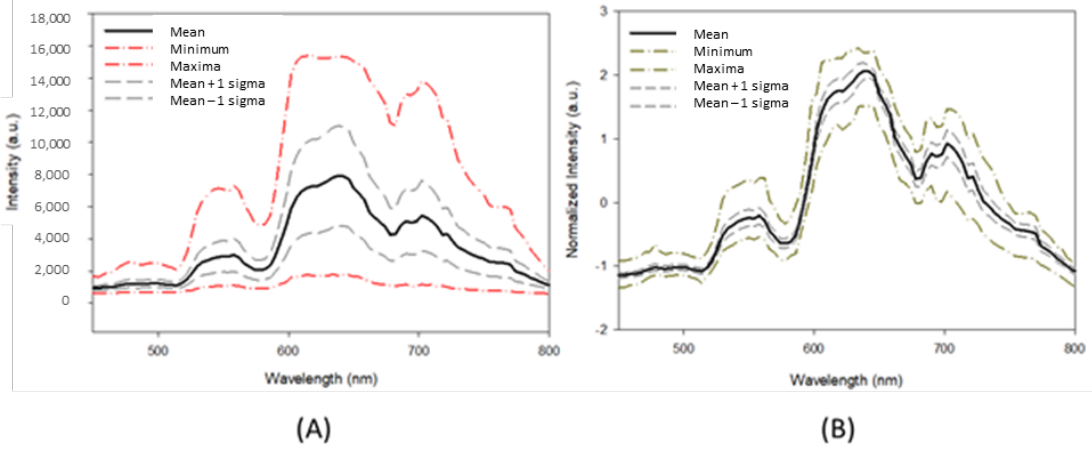
Figure 4. Raw ( A ) and preprocessed ( B ) Salmonella spectral profiles for the calibration dataset. High collinearity between bacterial species is an issue that should be taken into con- sideration. Because PCA utilizes an orthogonal transformation of the spectra to calculate the PCs, this aids in negating the influence of collinearity in the classification model. An advantage of SIMCA is that it is sensitive to dissimilarities between objects [22], which is significant given the close spectral relationships between bacteria. Eliminating these false